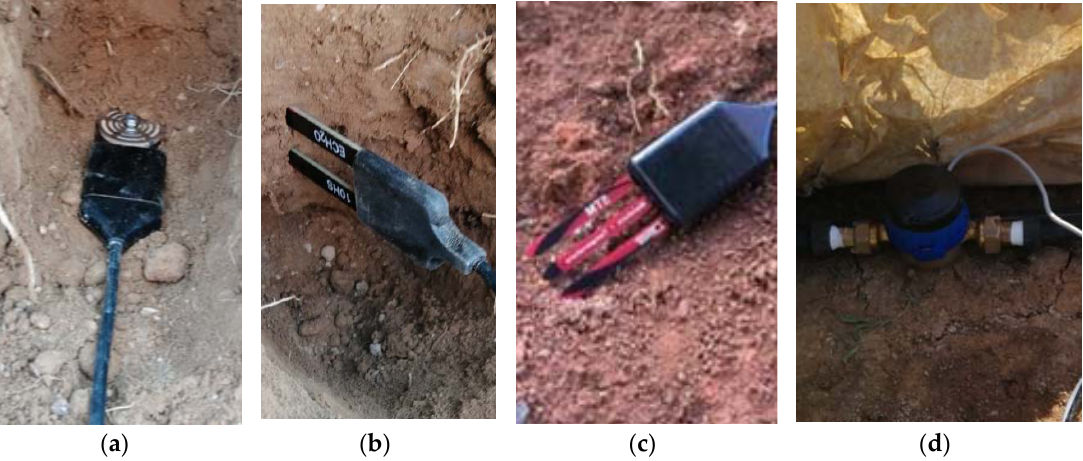
Figure 2. ( a ) Soil matric potential sensor MPS6. ( b ) Soil water content sensor 10HS. ( c ) Soil water content, temperature, and electrical conductivity (EC) sensor 5TE. ( d ) Water flow meter device JS04. Each node samples the variables every 15 min and sends the information to a data